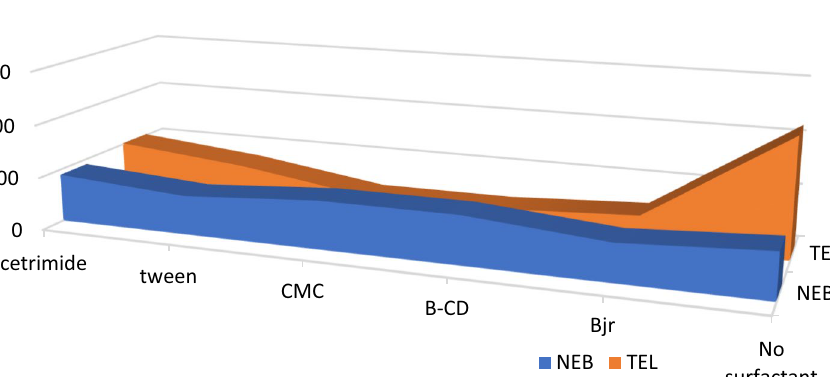
Figure 9. Effect of organized media on the relative synchronous fluorescence intensity of (100.0 ng/ mL) for each NEB and TEL.